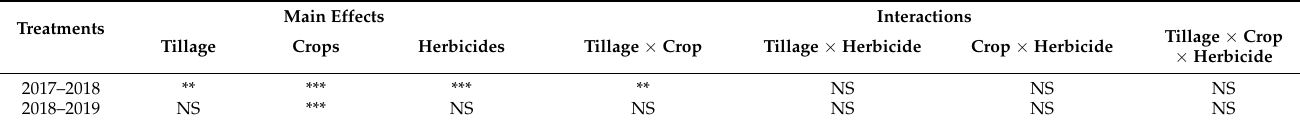
Table 3. Results of main effects and interactions from three-way ANOVA of G. coronaria densities for 2017–2018 and 2018–2019.